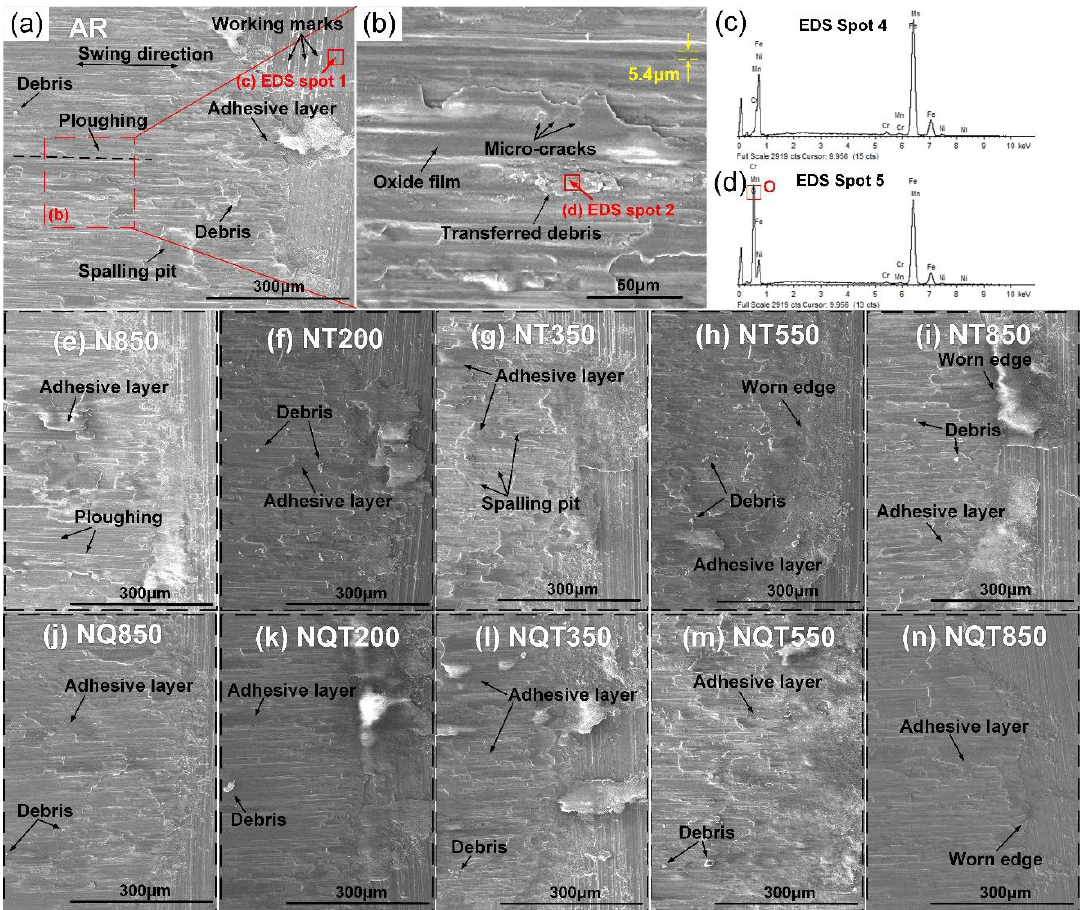
Figure 13. Scanning electron microscope ( SEM) morphologies and energy spectra of worn surface: magnification of AR state ( a ) at 400× and ( b ) at 1600×; Energy dispersive spectrometer (EDS) spectrum of ( c ) spot 4 (unworn surface) and ( d ) spot 5 (transferred debris); magnification of ( e ) N850, ( f ) NT200, ( g ) NT350, ( h ) NT550, ( i ) NT850, ( j ) NQ850, ( k ) NQT200, ( l ) NQT350, ( m ) NQT550 and ( n ) NQT850